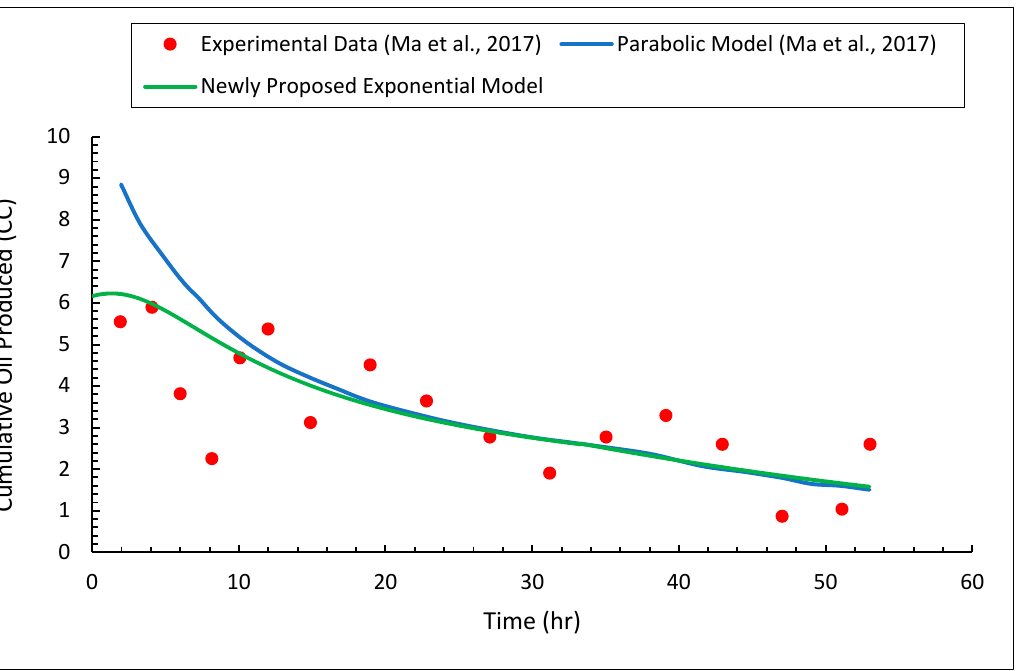
Figure 26. Comparison of the oil production rate estimated by the newly proposed exponential model, experimentally measured oil production rate [3], and oil production rate estimated by the parabolic model proposed by Ma et al. [3] in test #2.